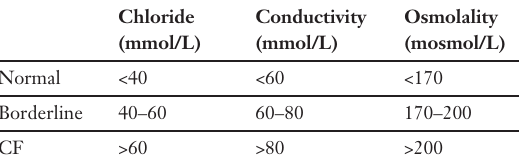
Table 1 Sweat test analysis – normal values [1, 7, 10, 13, 25, 29].